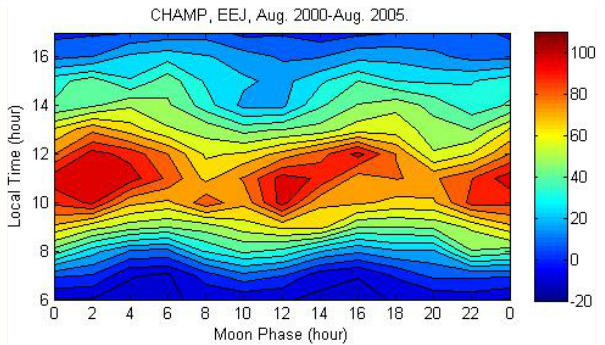
Fig. 1. Local time variation of the electrojet lunar tidal signal. Global averages of EEJ peak current densities (mA/m) are shown.